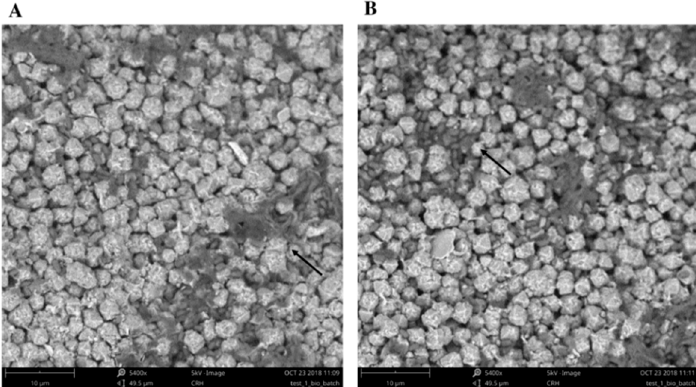
Figure 6. SEM-EDS images of B. cereus biofilm on zeolite. The arrows evidence the presence of biofilm on the surface of the zeolite, perspective 1 ( A ) and perspective 2 ( B ).